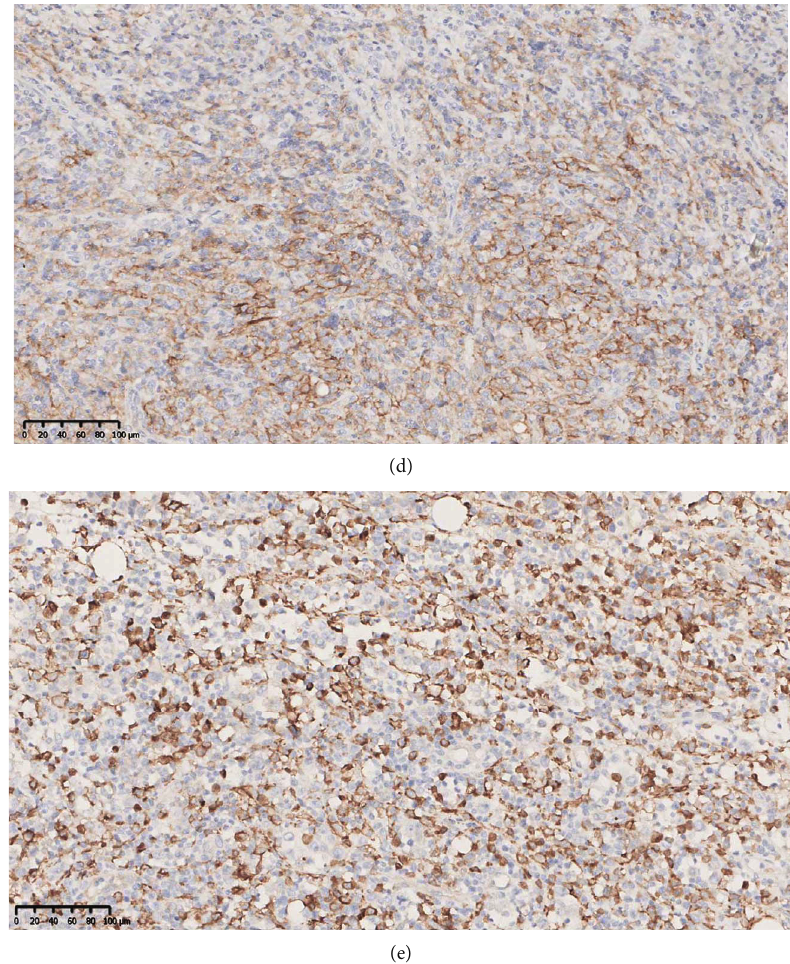
Figure 2: Immunohistochemical results of DLBCL (EnVision method, original magni fi cation 200x) (a – e). (a) Negative control, (b) positive control, (c) PD-L1 weakly positive expression on oncocytes, (d) PD-L1 moderately positive expression on oncocytes, and (e) PD-L1 strong positive expression on oncocytes. DLBCL: di ff use large B cell